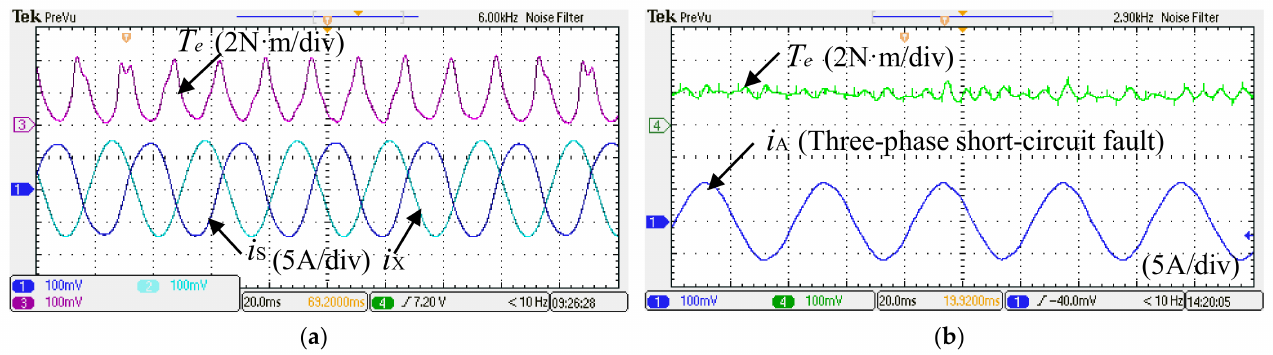
Figure 19. Output torque and SCC waveform under single-phase and three-phase short circuit fault. ( a ) Single-phase short circuit fault, ( b ) three-phase short circuit